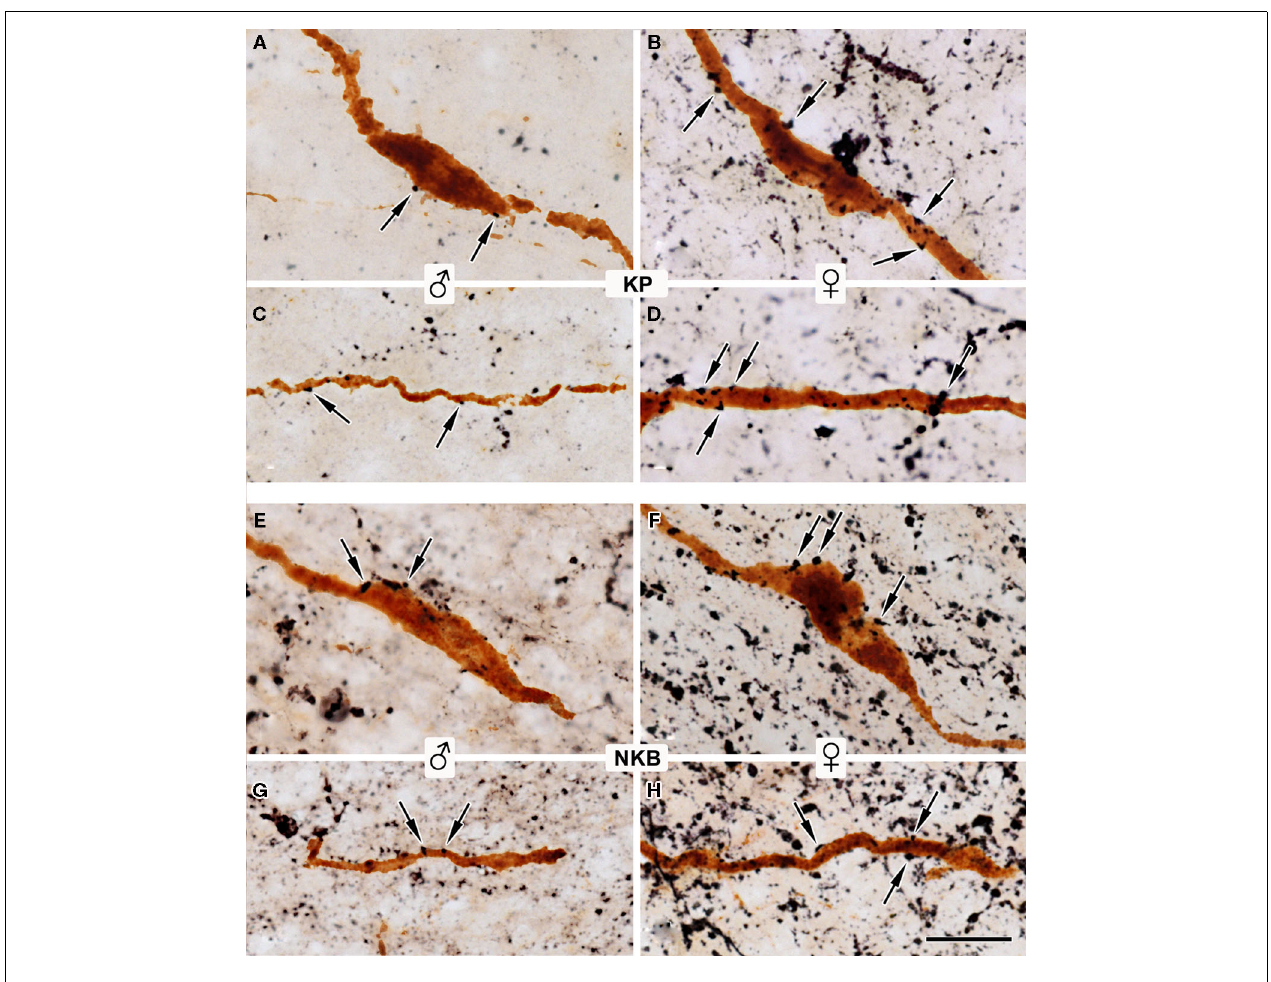
FIGURE 6 | Identification of kisspeptin-IR and preproNKB-IR afferent contacts on GnRH-IR neurons of the Inf. Sections double-labeled for kisspeptins (KP) and GnRH (A–D) or preproNKB (NKB) and GnRH (E–H) with the combined use of silver– gold-intensified Ni-DAB and